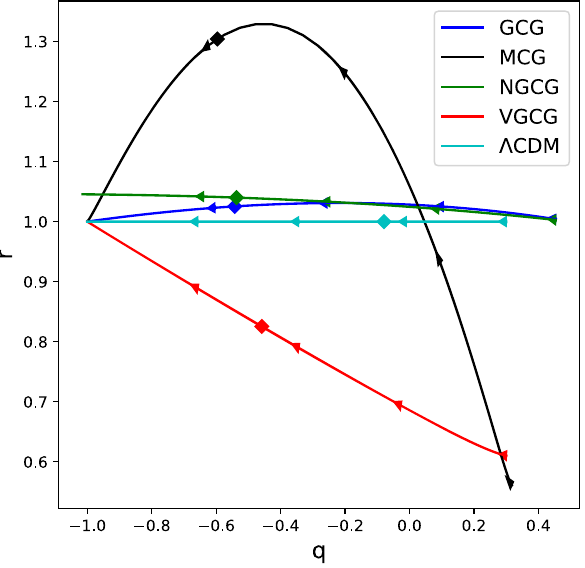
Fig. 9 The same as Fig. 8, but for the evolution of the pair ( r , q )